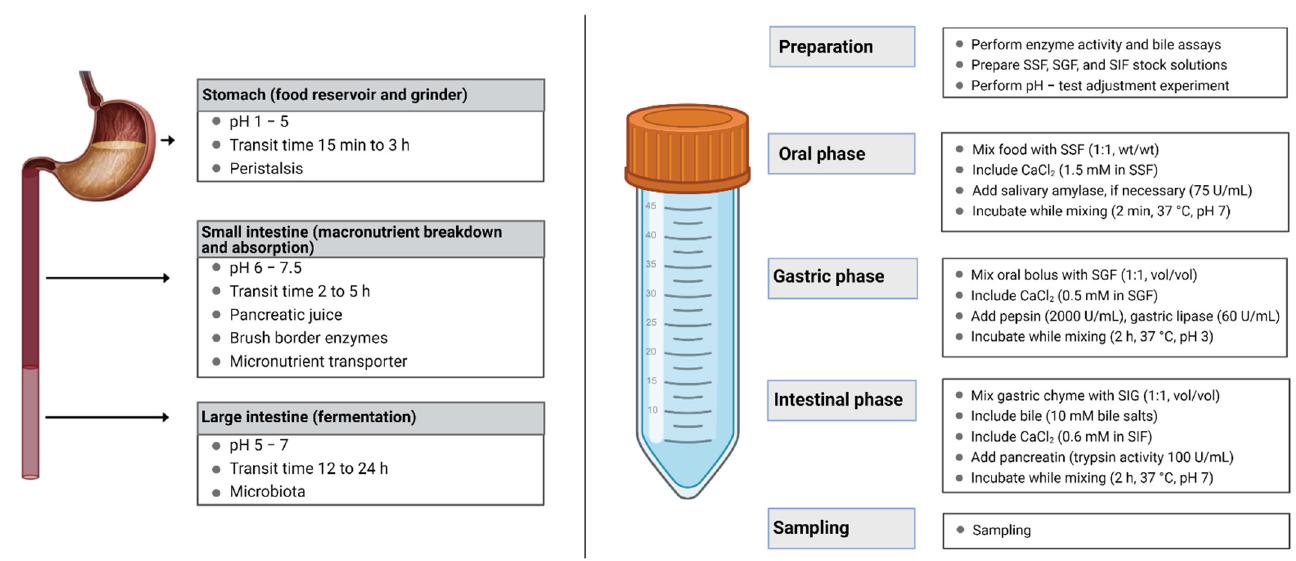
Figure 2. Region specificity and role of gastrointestinal tract during food digestion ( left ) and flow diagram of in vitro INFOGEST digestion protocol ( right ). This figure is reproduced from Li, et al. [31].